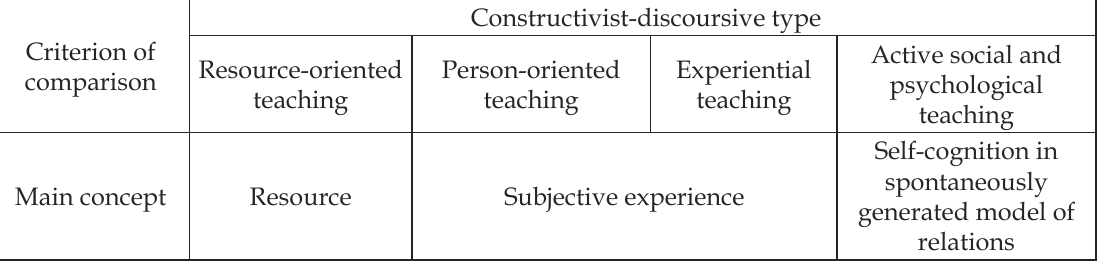
Tab. 1. Characteristics of resource-oriented method of teaching as compared with constructive-discoursive